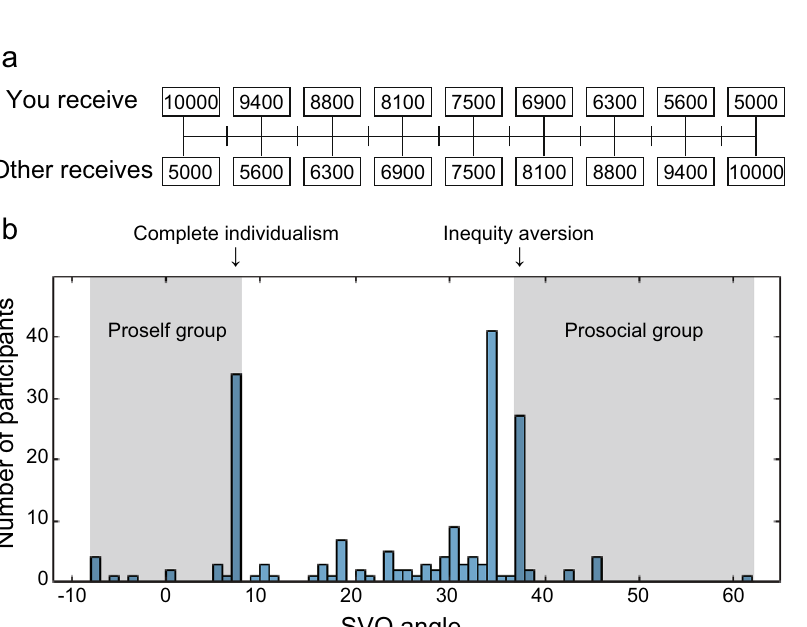
Figure 1. Sequential two-choice Markov decision task. ( a ) The probability transition structure of the task. Each state at the first choice, second choice, and outcome is composed of a geometric figure. The first stage starts with a common figure. The participant chooses left or right, and probabilistically (70%/30%) transitions to the corresponding next figure. In the second stage, the participant again chooses left or right, and finally arrives at a figure that is associated with a different monetary reward (0, 10, or 25 yen). ( b ) Time sequence of the task. First, the fixation point is presented, and then the figure of the first stage is presented. The participant makes a first choice within 2 s, and after the fixation point is presented again, the participant moves to the second stage. When the figure of the second stage is presented, the participant makes a second choice within 2 s. After the presentation of the fixation point, the reward information is given, and after the inter trial interval, the next trial starts.